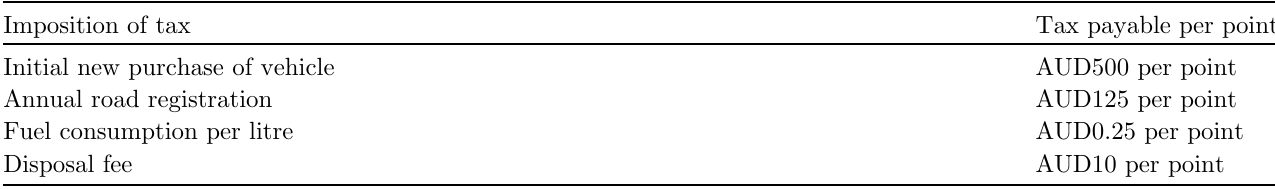
Table 3. Taxing points converted to luxury energy